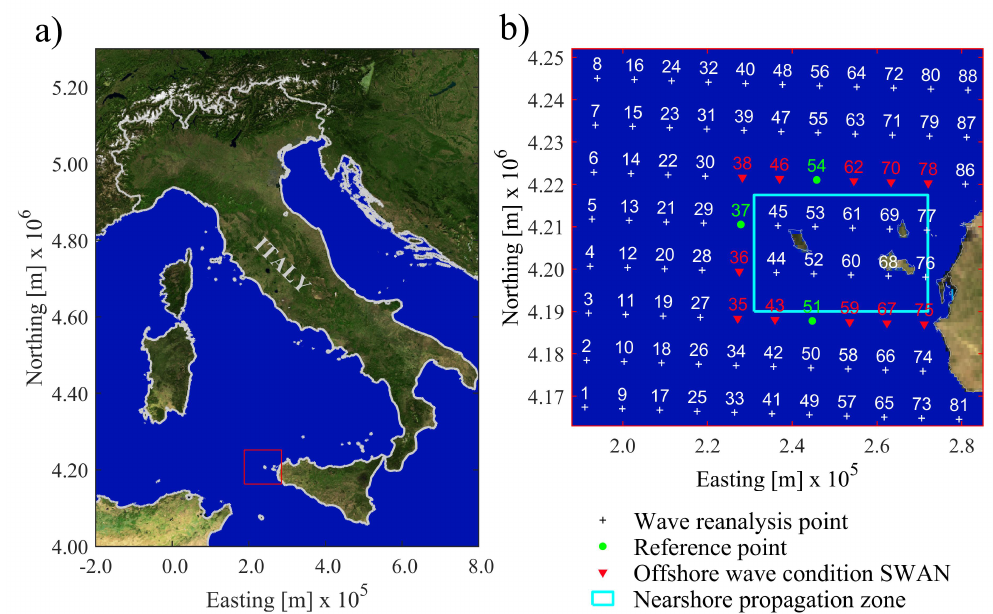
Figure 2. ( a ) map of Italy and Aegadian Islands, the red rectangle shows the area magnified in the right subplot; ( b ) zoom of the studied area, the cyan rectangle shows the numerical near-shore domain, the crosses show the reanalysis data points, the triangles show the offshore input wave points and the green circles show the reference points used in the offshore energy analysis. The reference coordinate system is ED50/UTM zone